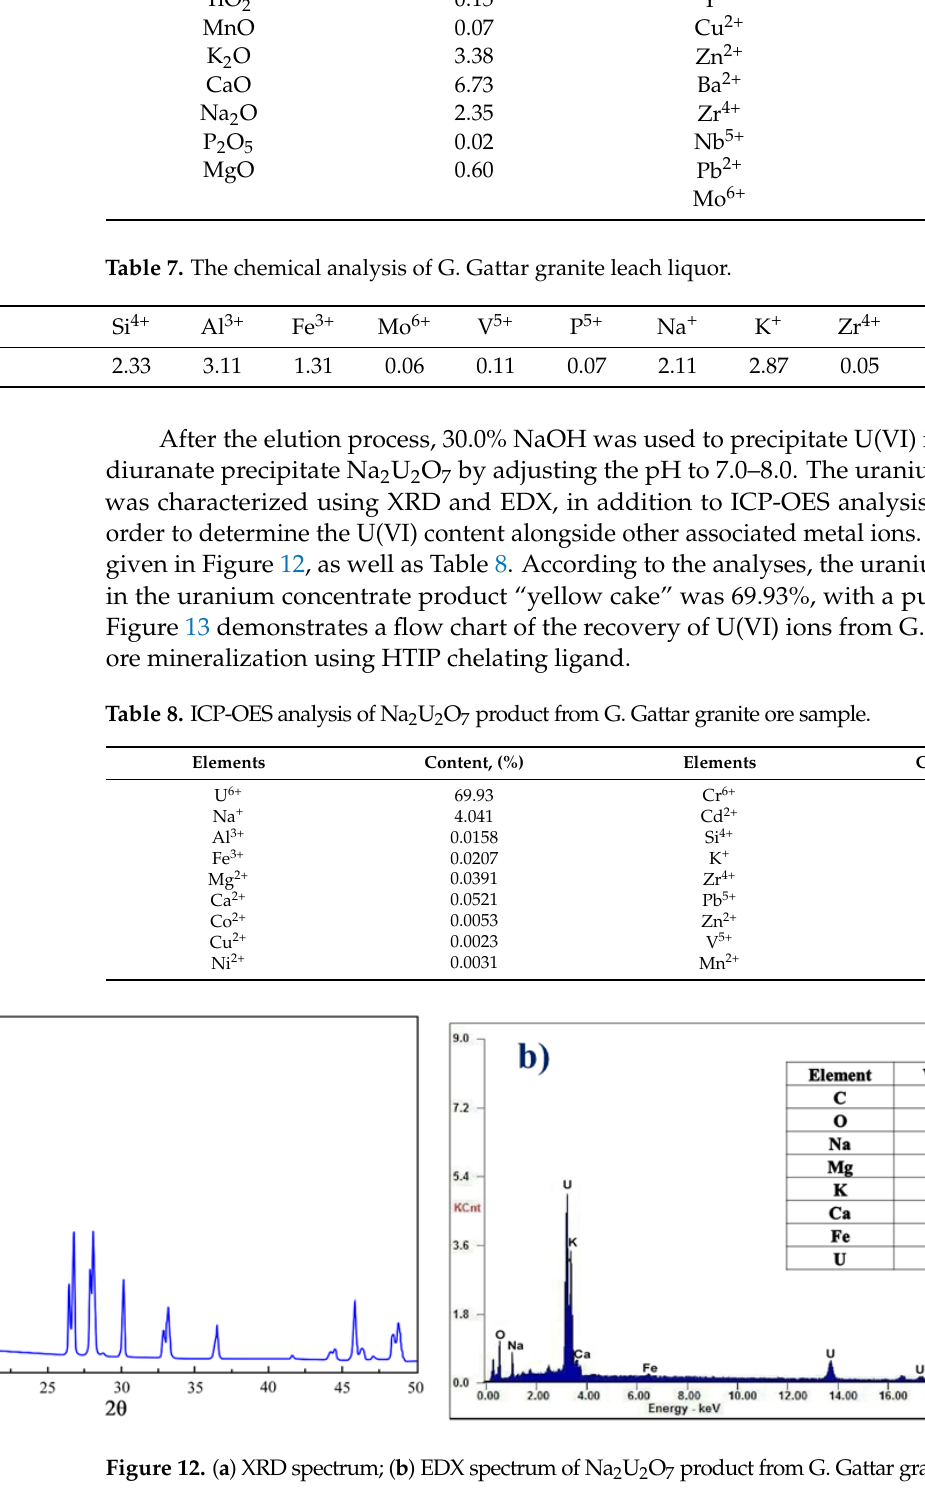
Figure 13. Flow chart illustrating the production of Na 2 U 2 O 7 from G. Gattar granite ore sample using HTIP chelating ligand.